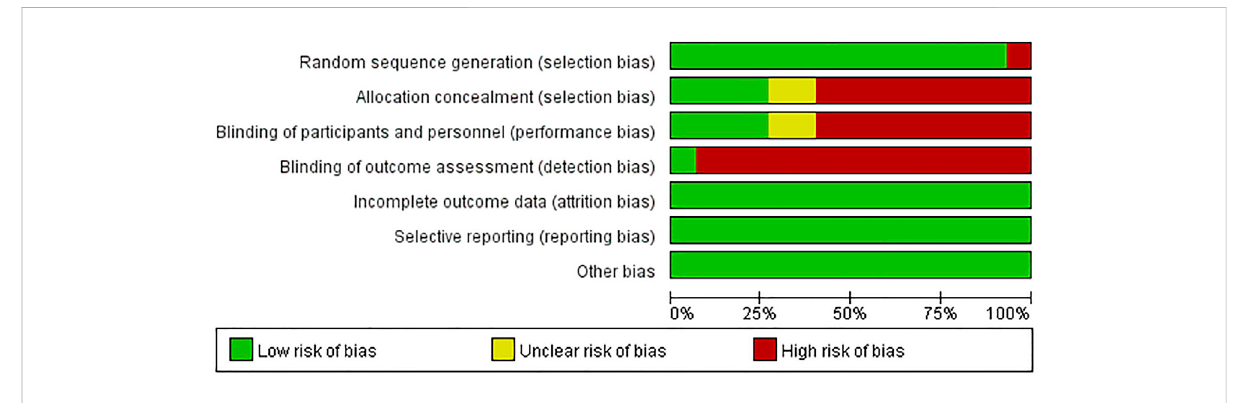
FIGURE 2 Risk of bias graph for included